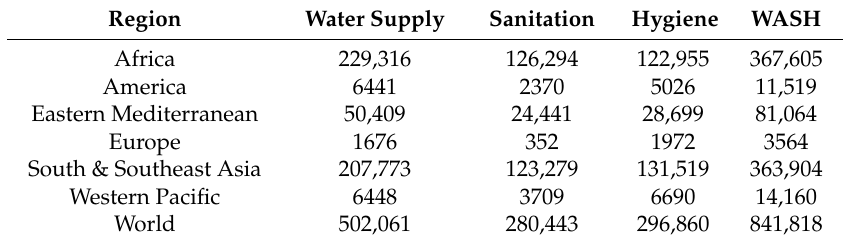
Table 3. Diarrheal Disease Mortality Attributed To Poor Water Supply, Sanitation, and Hygiene in Low-and Middle-Income Countries, Regional and Risk Factor Breakdown. Region Water Supply Sanitation Hygiene WASH Africa 229,316